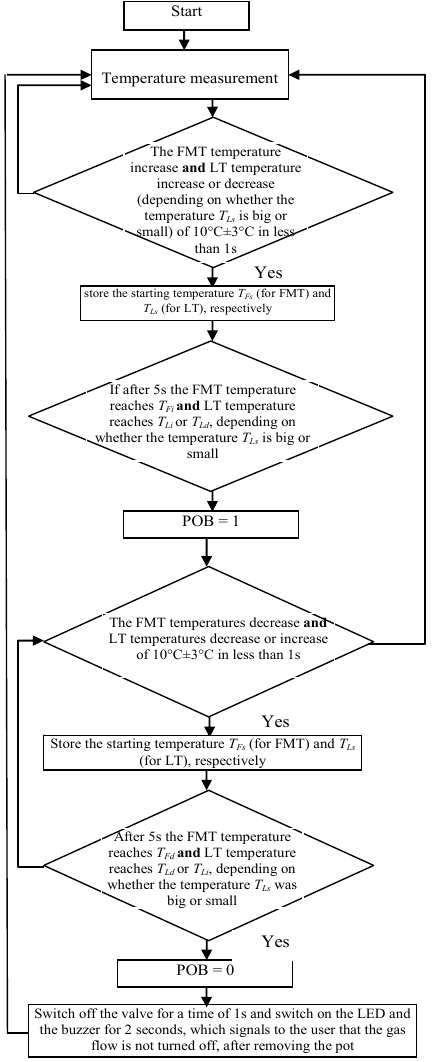
Figure 16. Temperature changes measured by the linear thermocouple located in position 3.